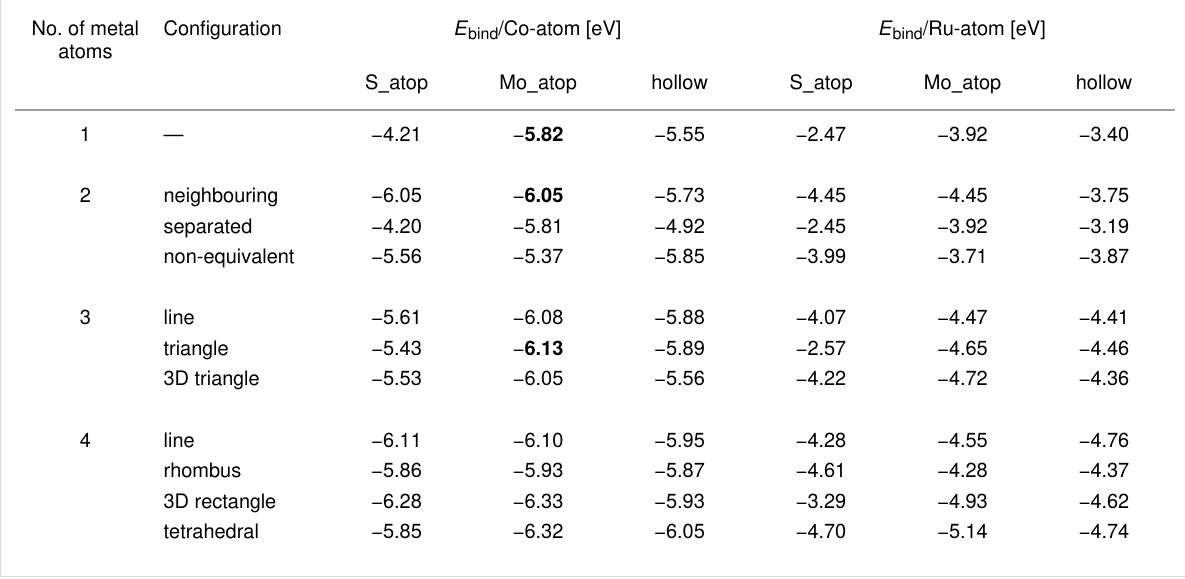
Table 1: Computed binding energies for Co 1 , Co 2 , Co 3 , Co 4 , Ru 1 , Ru 2 , Ru 3 and Ru 4 on a MoS 2 ML for various atom configurations using Equation 1. For the “non-equivalent” configurations for two metal atom adsorption, the column “S_atop site” has atoms at sites S_atop and Mo_atop, “Mo_atop site” has atoms at S_atop and hollow, and “hollow site” has atoms at Mo_atop and hollow. No. of metal